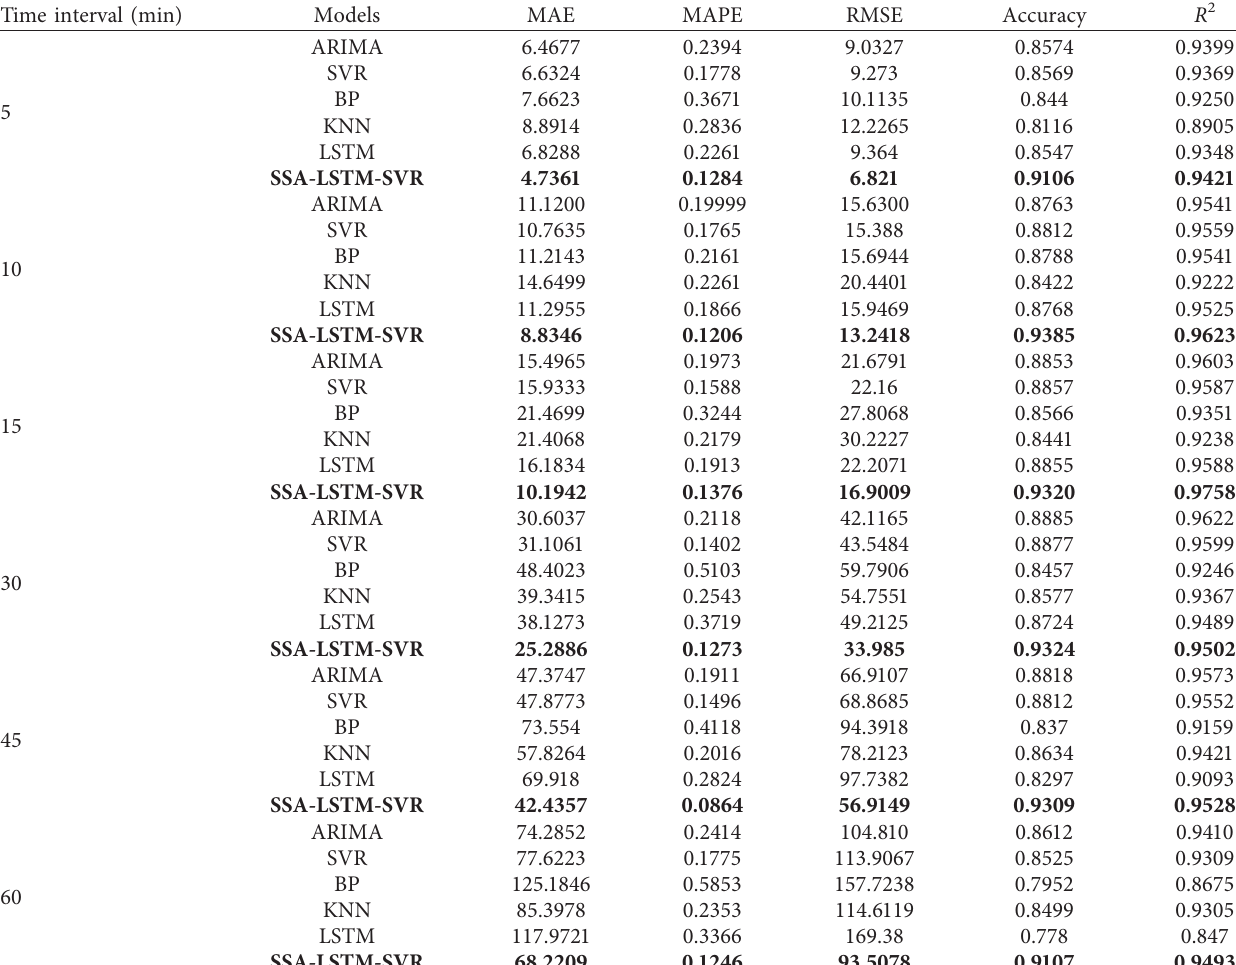
Table 1: Performance comparison of prediction models (Guiyang North